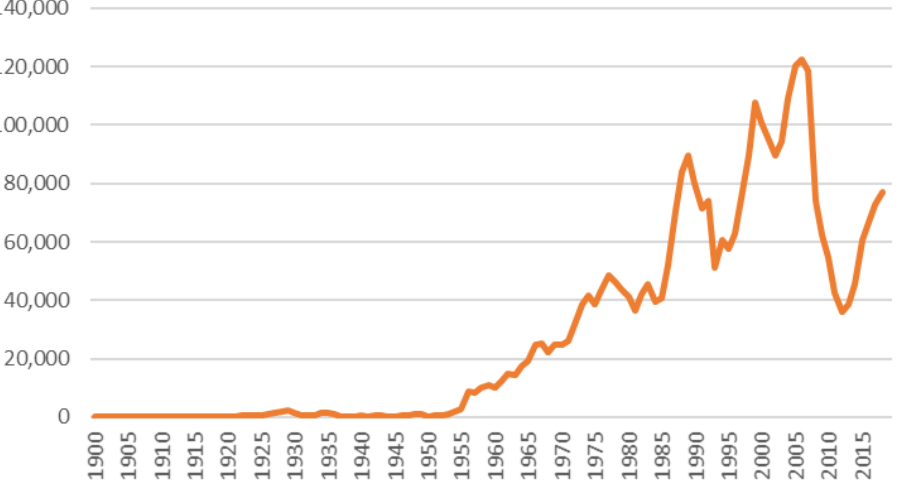
Figure 5. Vehicles registered per year since 1901, province of Valencia. Data source: DGT official statistical yearbooks.